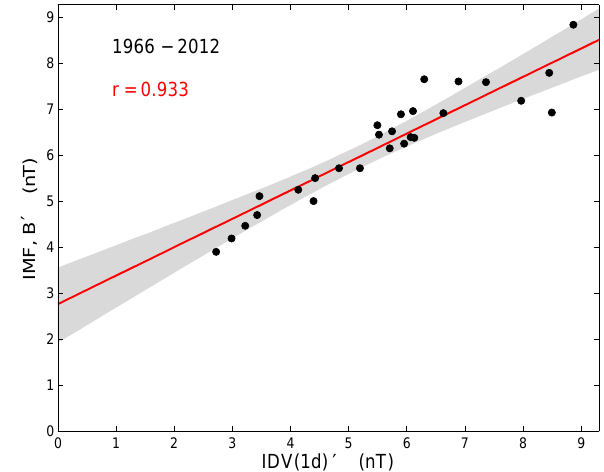
Fig. 3. The histogram shows the observed distribution of values of the ratio [ B / B sin 4 (θ/ 2)] for the annual means shown in Fig. 2b. The dashed line is the best-fit Gaussian of the same mean and standard deviation (3.251 and 0.369, respectively).